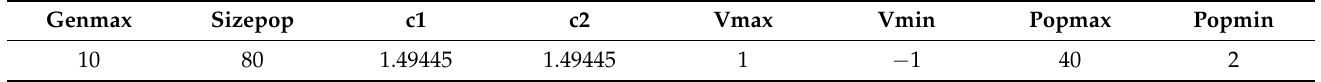
Figure 8. Penalty parameters, number of decomposition moduli, optimal fitness. Using the results of the algorithm to set the VMD model parameters, the four com- ponents which are depicted in Figure 9 are decomposed after measuring the input of the signal. IMF1, the 1/ f noise extracted from the white noise background, is also included among them. The extracted 1/ f noise power spectral density is shown in Figure 10, and it